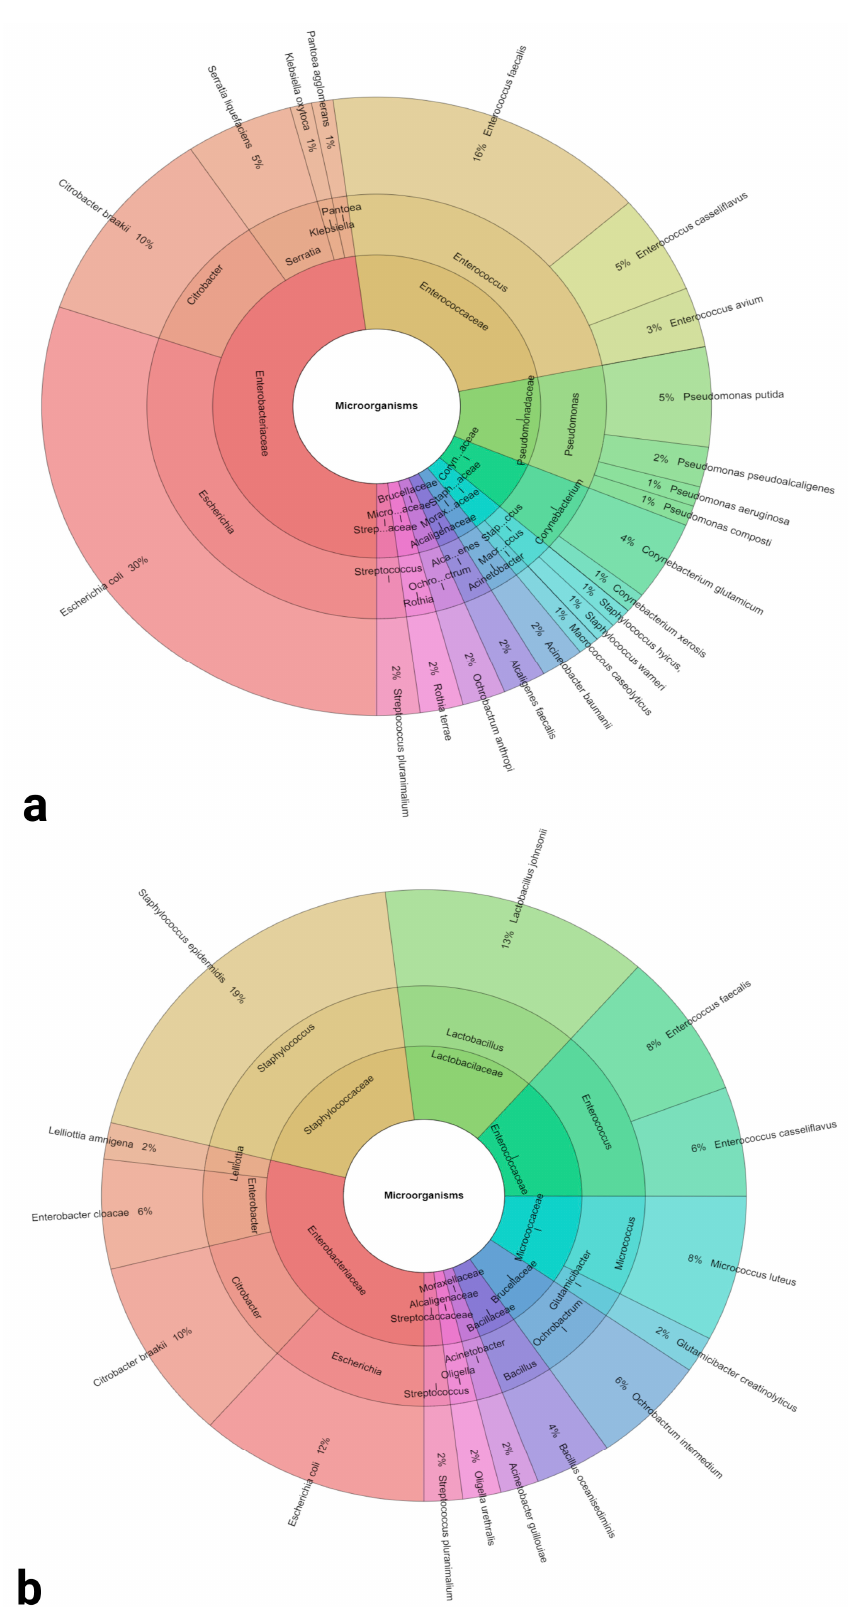
Figure 1. Krona charts of the bacteria identified in semen collected from Lohmann Brown ( a ) and ROSS 308 ( b ) roosters. Outer ring: species, middle ring: genus, inner ring: family. Table 1. Bacterial profiles of semen samples collected from Lohmann Brown and ROSS 308 roosters.